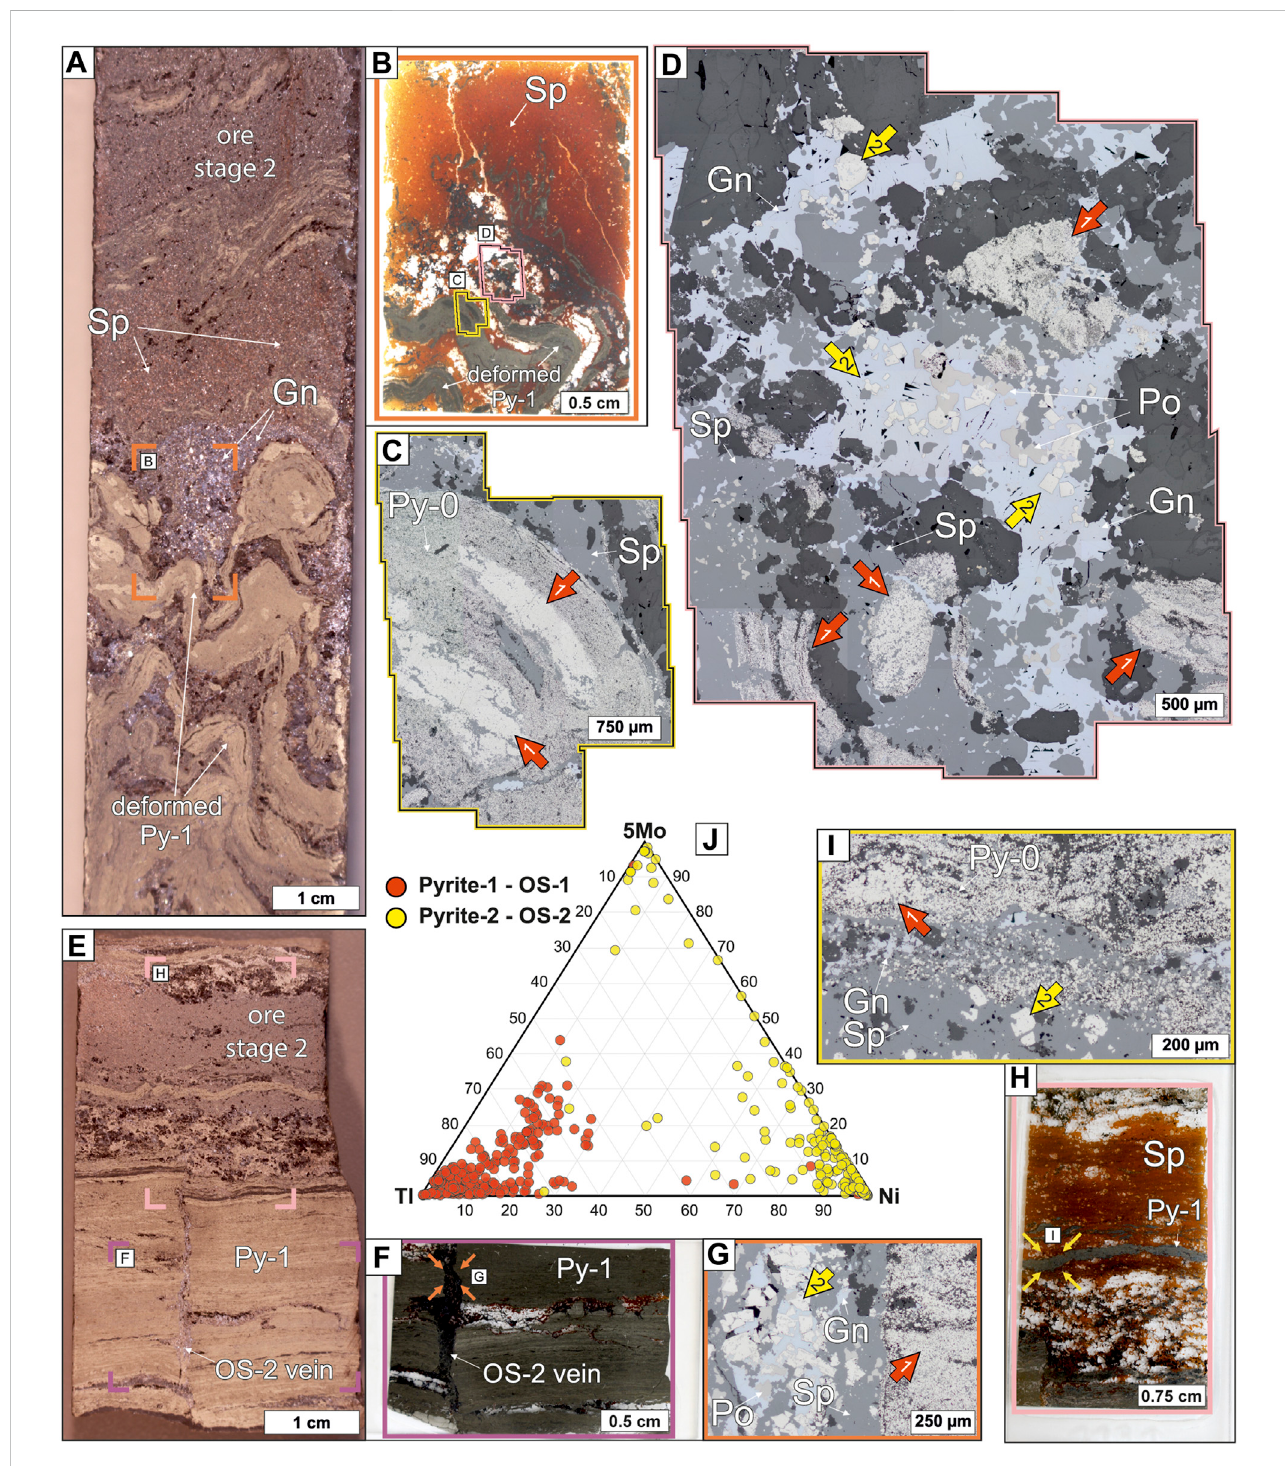
Ore stage 1 and 2 massive sul fi de samples from the George Fisher deposit containing anhedral Py-1, euhedral Py-2, sphalerite (Sp), galena (Gn), and pyrrhotite (Po). (A) A hand specimen photograph ofsamplePRK798C013. The orangerectangle denotesthelocation of (B) . (B) A photograph ofathinsection of deformed Py-1 in a massive sphalerite (Sp) breccia. The yellow and pink polygons denote the location of (C,D) , respectively. (C) A re fl ected light photomicrograph of deformed Py-1 (red arrows). (D) A re fl ected light photomicrograph of deformed, Py-1 (red arrows), which iscross-cut and replaced by ore stage 2 sphalerite (Sp), galena (Gn), pyrrhotite (Po), and euhedral Py-2 (yellow arrows). (E) A hand specimen photograph of sample PRK798C011. The purple and pink rectangles denote the location of (F,H) , respectively. (F) A photograph of a thin section of an ore stage (OS) 2 vein that cross-cut Py-1. The orange arrows denote the location of (G) . (G) A re fl ected light photomicrograph of Py-1 (red arrow) cross-cut by an ore stage (OS) 2 vein containing euhedral Py-2, sphalerite (Sp), galena (Gn), and pyrrhotite (Po). (H) A photograph of a thin section of an ore stage 2 breccia containing euhedral Py-2, sphalerite (Sp), galena (Gn, not labelled), and pyrrhotite (Po, not labelled). The yellow arrows denote the location of (I) . (I) A re fl ected light photomicrograph of ore stage 2 sphalerite (Sp), galena (Gn), and euhedral Py-2 (yellow arrow) that have replaced and in fi lled after anhedral Py-1 (red arrow). (J) A ternary diagram of Tl, Ni, and 5*Mo abundances for Py-1 and